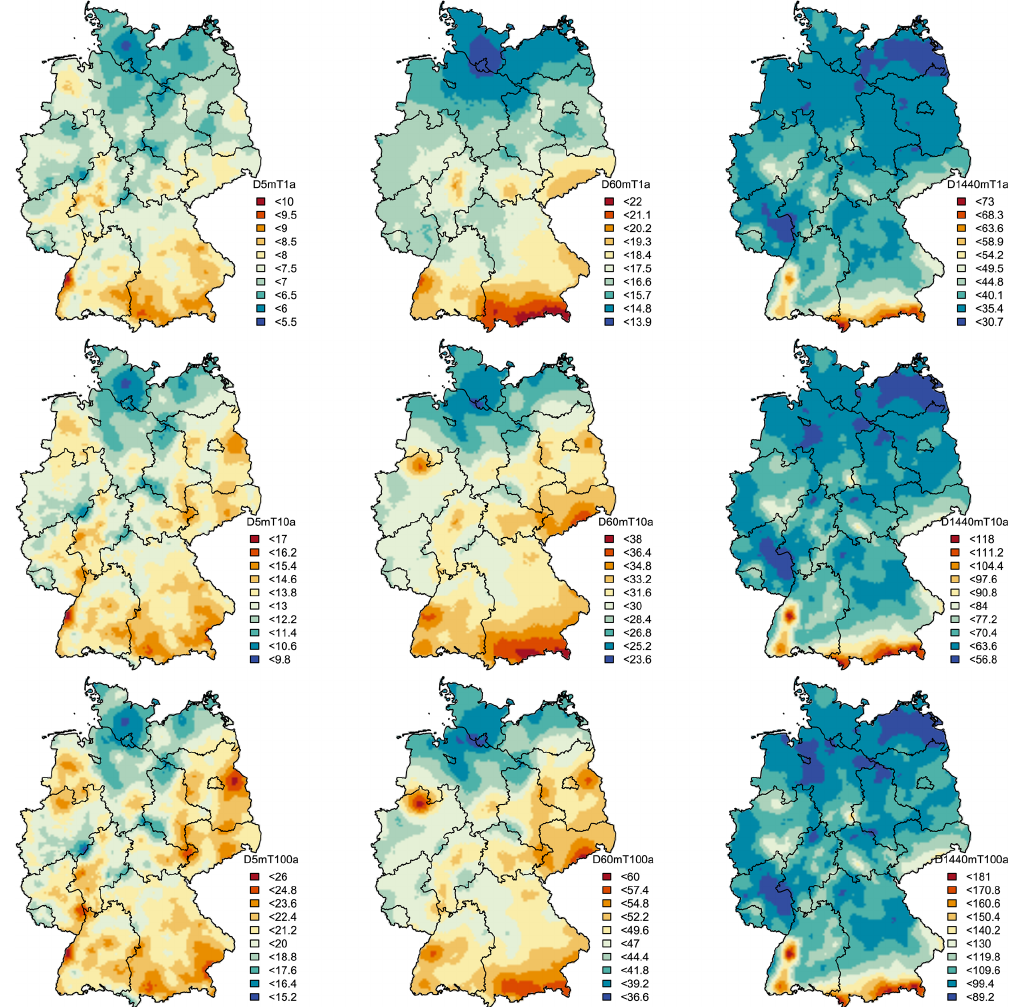
Figure 14. Obtained design rainfall (mm) maps for the whole of Germany from the KED[LS | SS] regionalisation approach derived for different durations ( D = 5, 60 and 1440min): first row – return period T[a] = 1 year, second row – return period T[a] = 10 years and third row – return period T[a] = 100 years. The black lines illustrate the borders of German federal